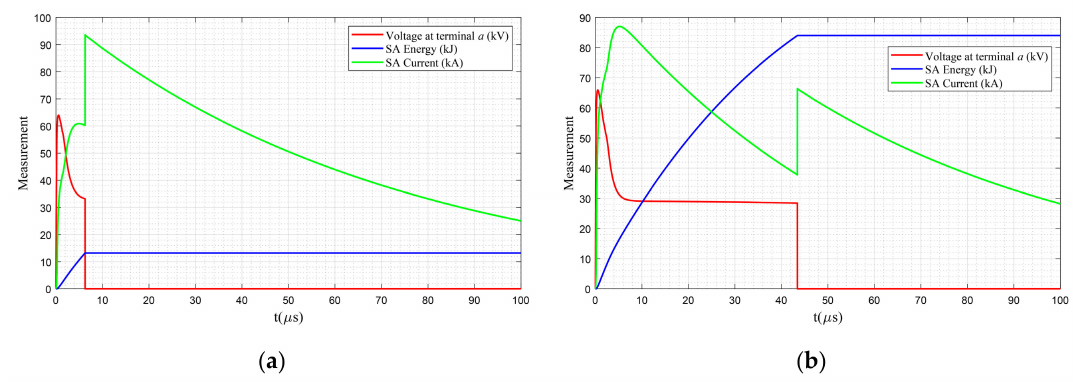
Figure 11. Failure of ( a ) SA-12a under 100 kV lightning impulse and ( b ) SA-12b under 125 kV lightning impulse.